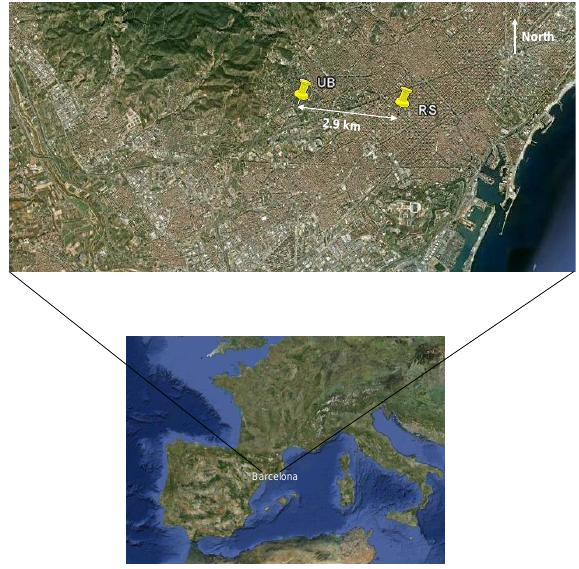
3 Fig. 1. Location of the sampling sites in Barcelona (source: Google